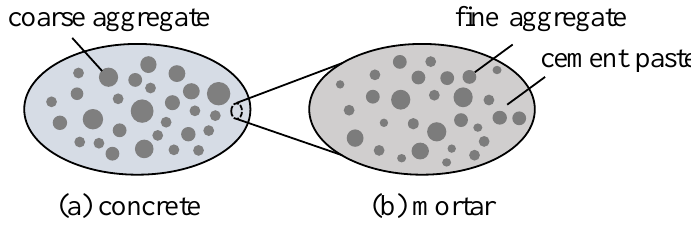
Figure 2. Material organogram of concrete in the form of two-dimensional sketches of three-dimensional representative volume elements: ( a ) concrete consisting of coarse aggregate inclusions, embedded in a mortar matrix, and ( b ) mortar consisting of fine aggregate inclusions, embedded in a cement paste